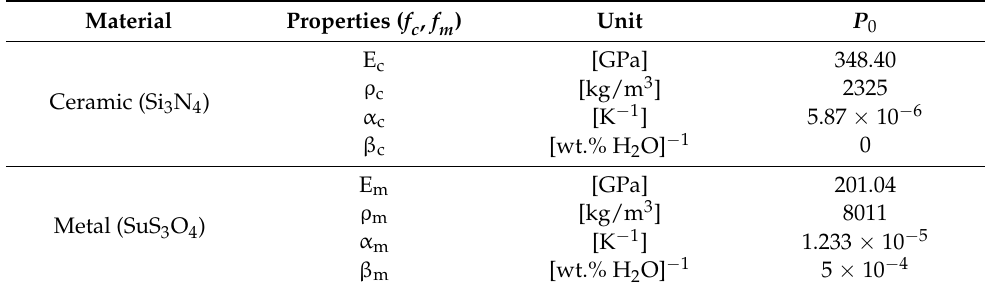
Table 1. Characteristic values of thermo-elastic properties ( f c , f m ) of ceramic (Si 3 N 4 ) and metal (SuS 3 O 4 )